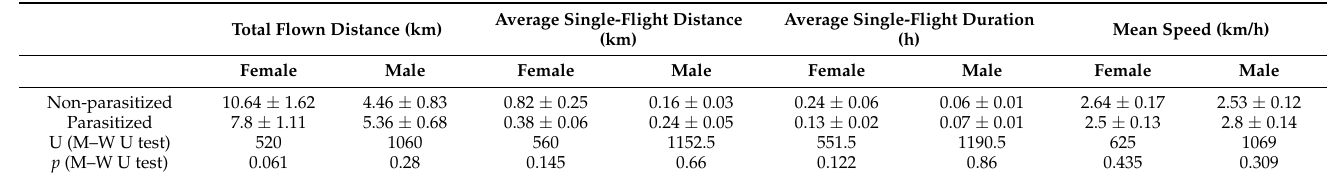
Table A3. Comparison of flight performance parameters between different parasitism statuses of Sirex nitobei .